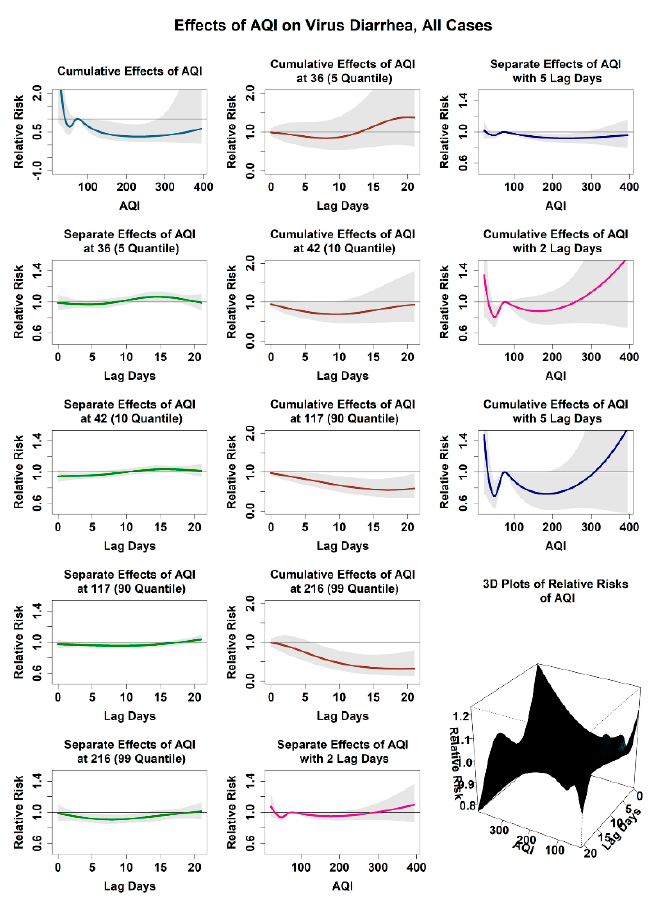
Figure 4. Effect of AQI on virus diarrhea in Jilin Province, all cases.